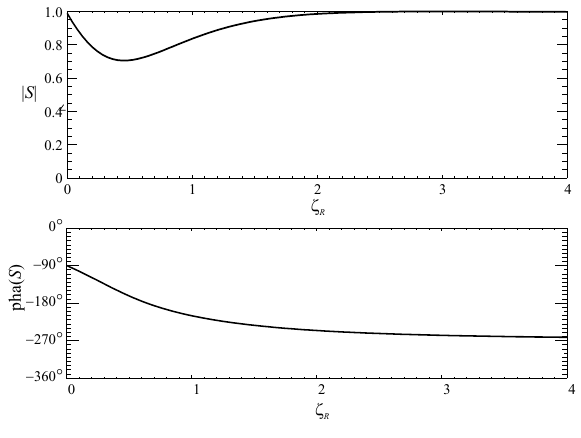
Fig. 4. Stokes constant when the effect of the resonance is included. No losses: = (ζ R ) = 0.